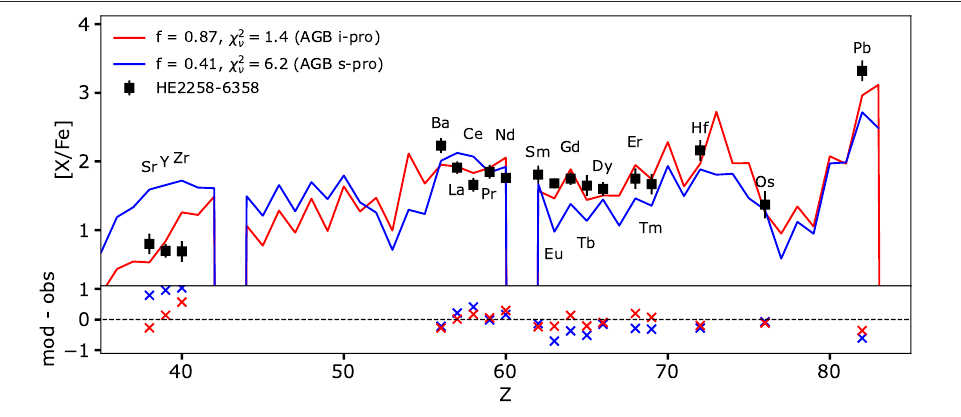
Figure 2. Best fits to the CEMP-r / s star HE2258-6358 using a 2 M (cid:12) AGB model with [Fe / H] = − 2 . 5 that experienced s-process only (blue) and using a 1 M (cid:12) AGB model with [Fe / H] = − 2 . 5 that experienced i-process (red). The method of fitting is described in the Section 6.2 of [1]. The dilution factor f (Eq. 8 and 10 in [1]) and the smallest χ 2 value (Eq. 7 in [1]) are indicated. The abundance data is from ν